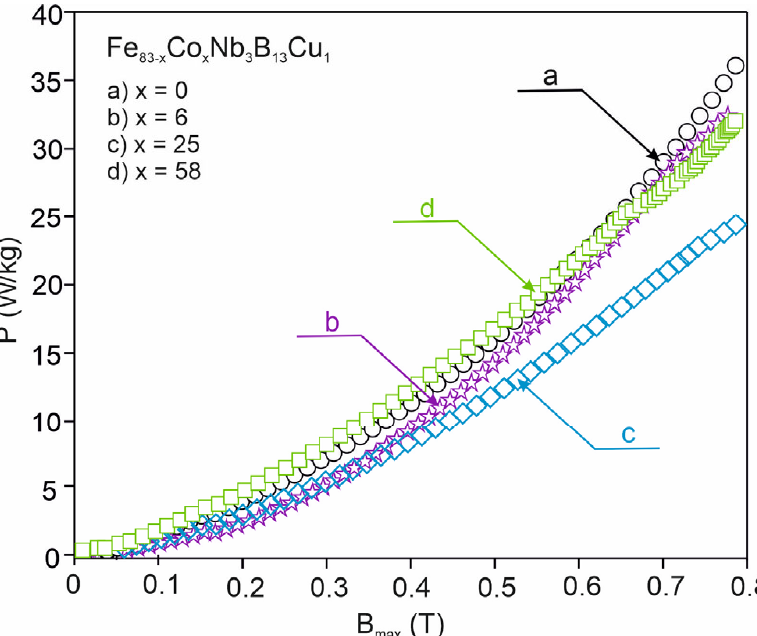
Figure 5. Core losses of Fe 83 − x Co x Nb 3 B 13 Cu 1 (x = 0 (a), 6 (b), 25 (c), and 58 (d)) alloys annealed at 750 K for 10 min measured for the 1 kHz frequency.